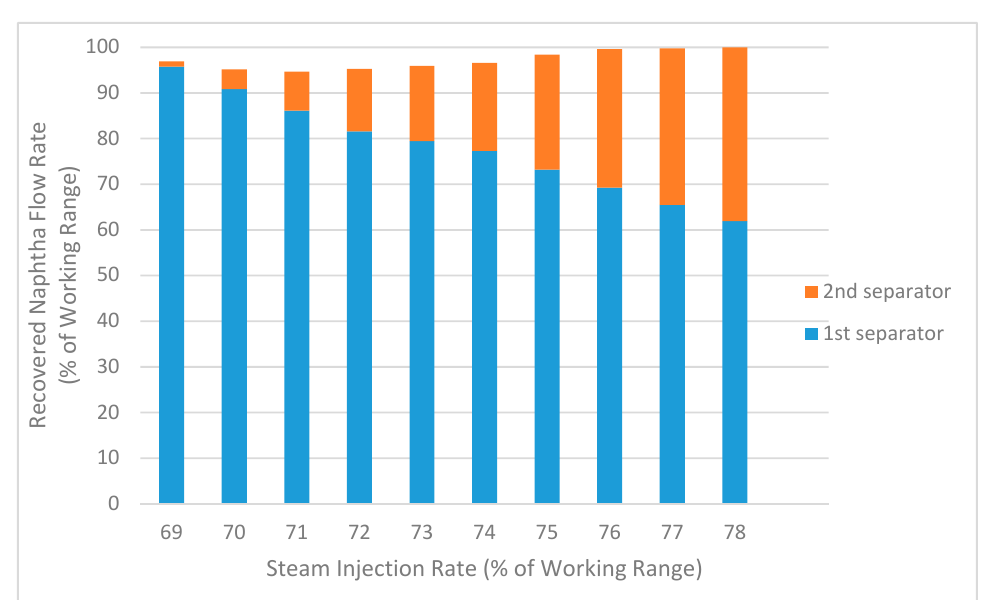
Figure 15. Impact of steam on naphtha recovery as predicted by Aspen Plus model.